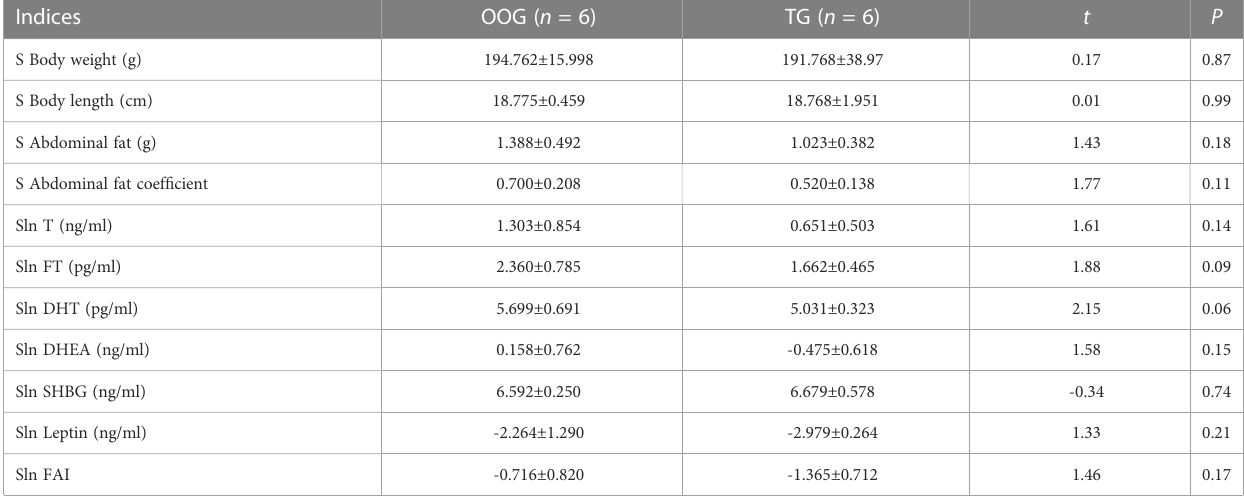
TABLE 2 Comparison of body shape indices and blood circulating sex hormone indices in male offspring between OOG and TG ( (cid:1) x ± s